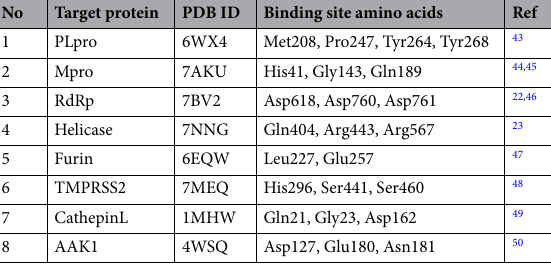
Table 1. The SARS-CoV-2 target protein PDBs and the binding site amino acid used in grid